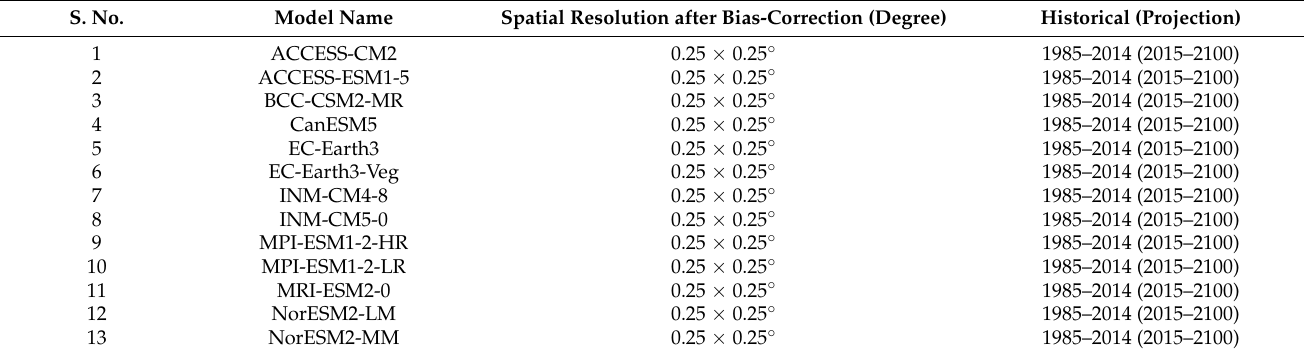
Table 1. CMIP6 ensemble models used in the current